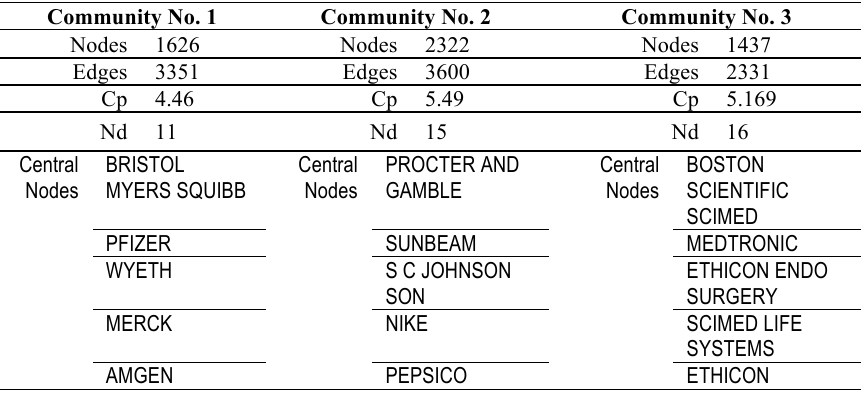
Table 3. The Six Biggest Communities in the Mobility Network The Six Biggest Communities in the Mobility Network Community No.